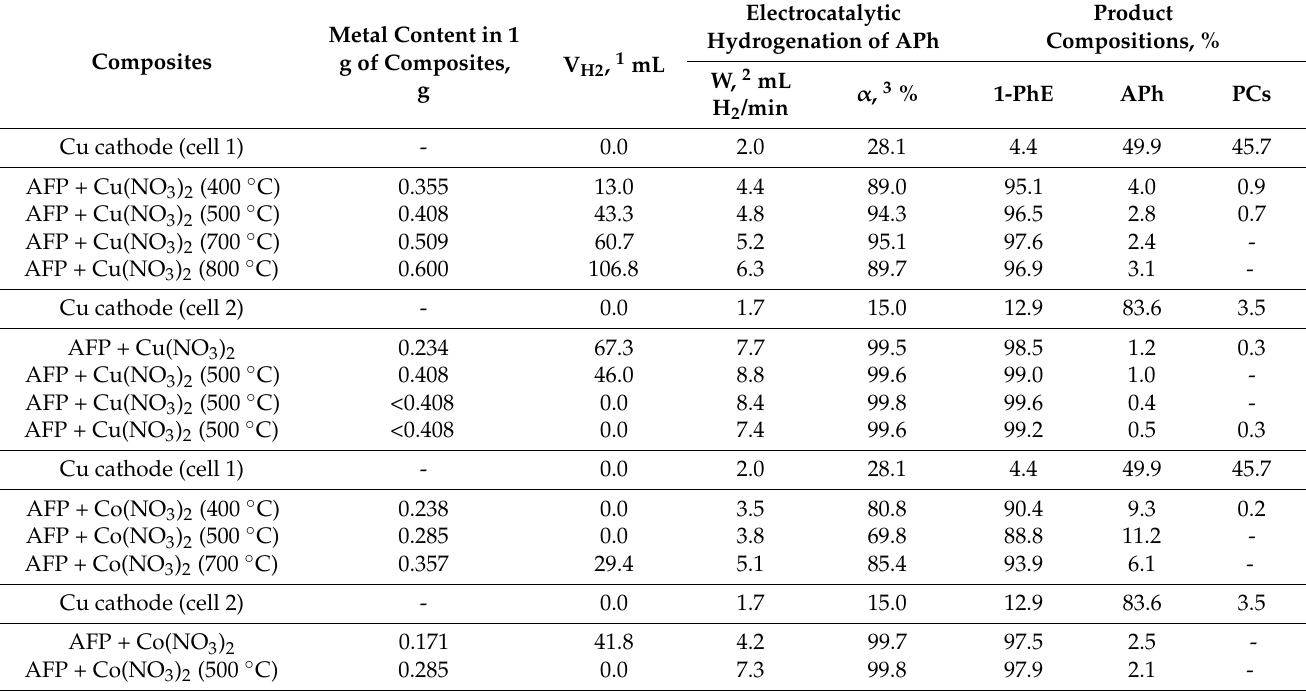
Table 2. The results of acetophenone electrocatalytic hydrogenation using Cu- and Co-containing AFP-carbon